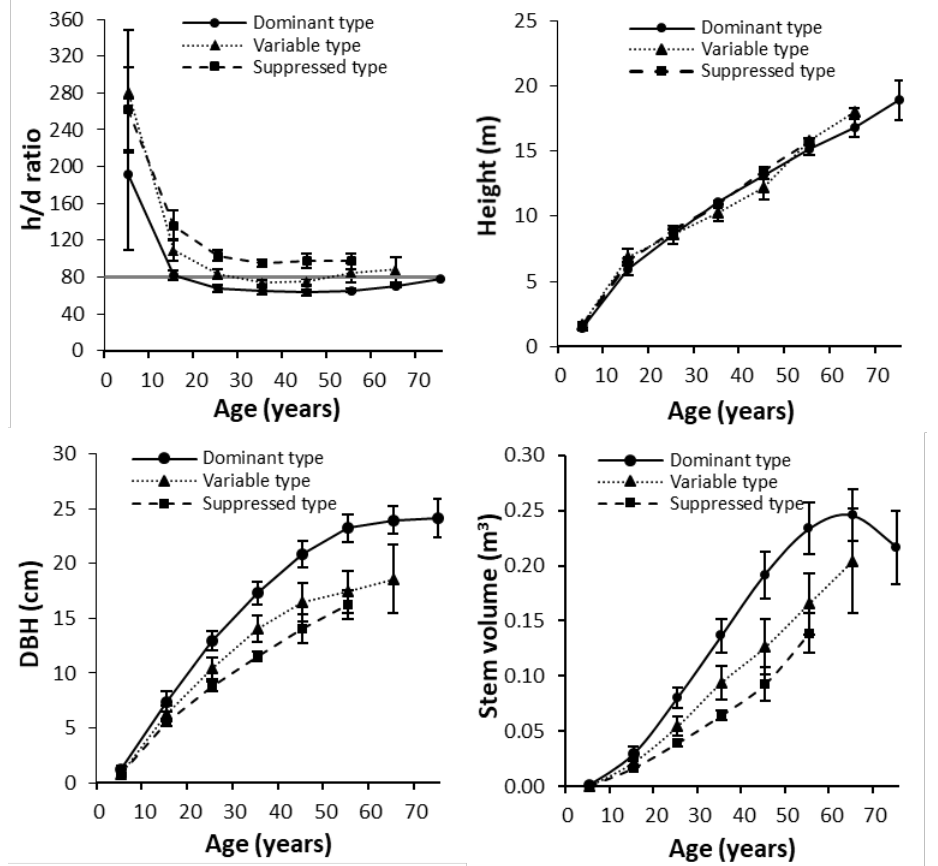
Figure 6. Development of each variable (mean value and standard error every ten years) from studied crop trees of each growth type: dominant type, variable type, and suppressed type. Top left : h/d ratio (80 indicates the limit value of stability), top right : height development; bottom left : diameter development and bottom right : volume development. The stem volume at 75 years of trees of dominant type has a lower number of trees than in previous ages (in the age of 75 years there was data from fewer trees to be considered in the mean value).